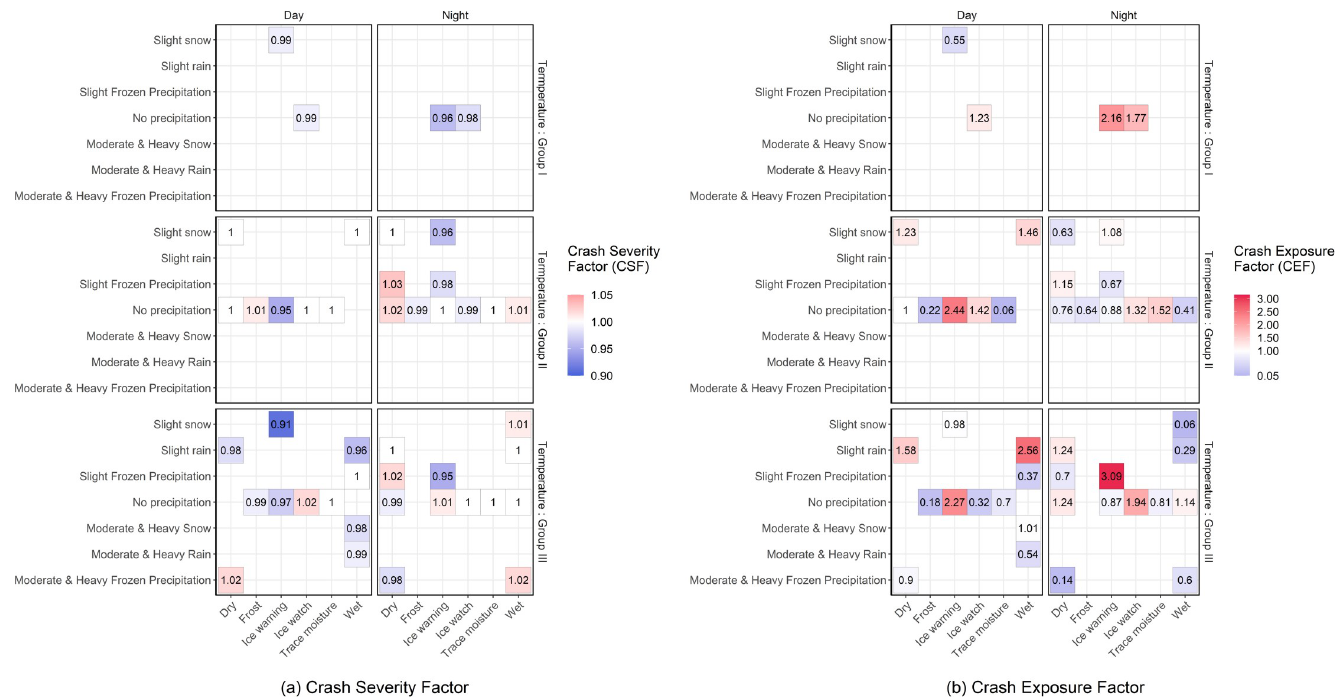
Fig 13. Crash severity and crash exposure factors for each road-weather combination under the prevailing traffic